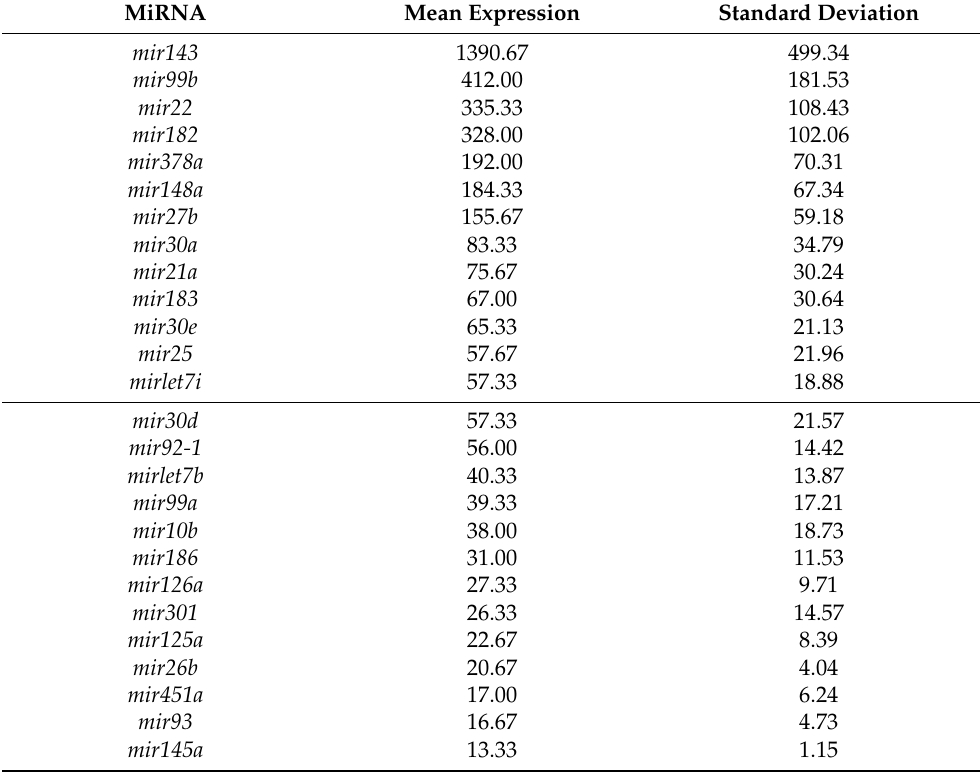
Table 1. MiRNA expressed in HL-1 EVs.